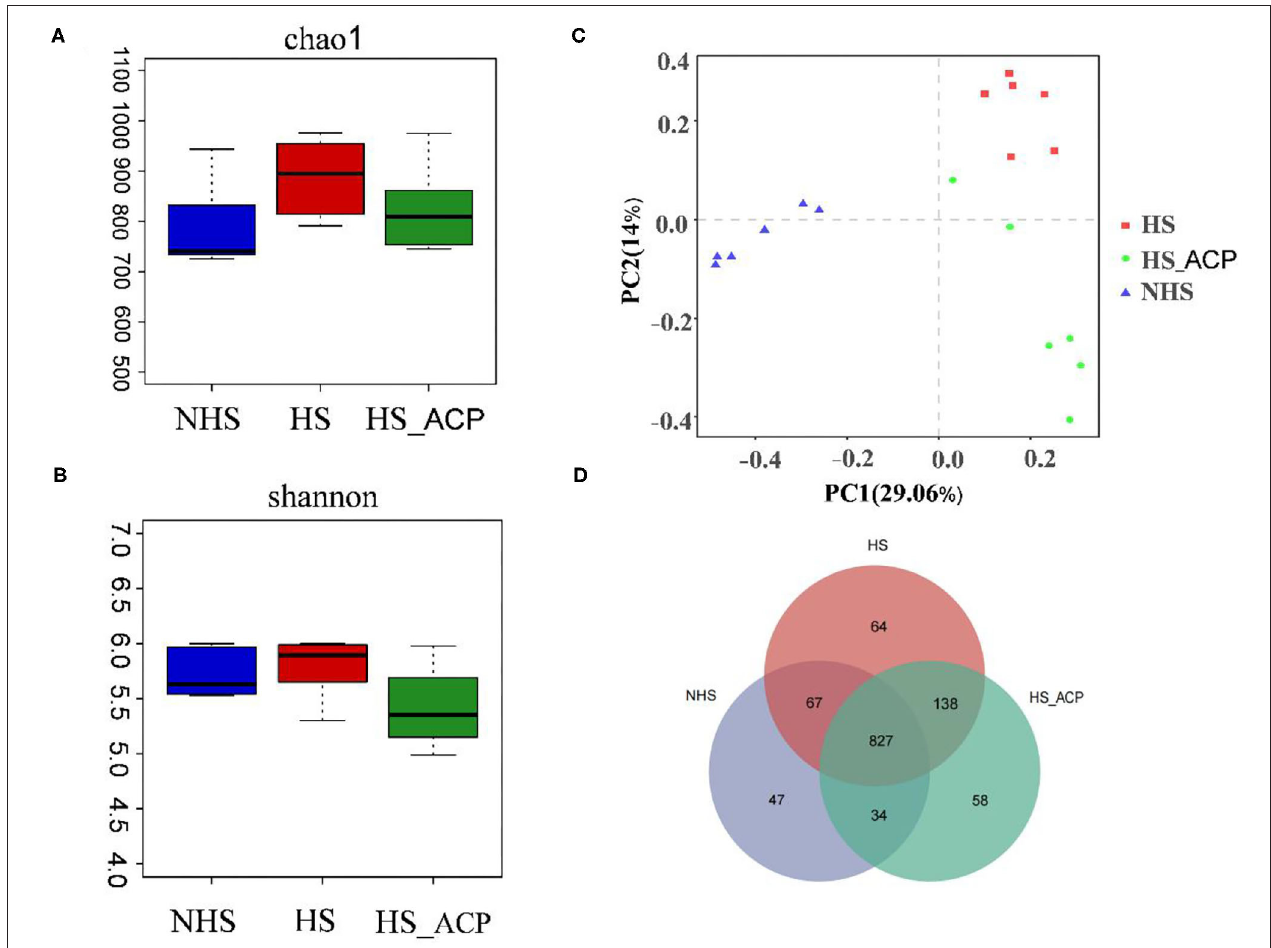
FIGURE 6 | Effect of adding ACP on microbial diversity in heat-stressed broilers. (A) Chao1 index, (B) Shannon entropy, (C) Principal component analysis of gut microbiota, (D) Similarity and difference of bacteria compositions in different experimental groups at the operational taxonomic unit (OTU) level.